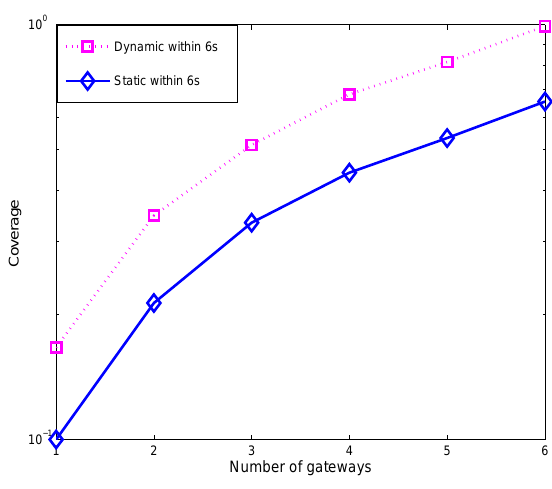
Figure 5. Dynamic vs. Static deployment.